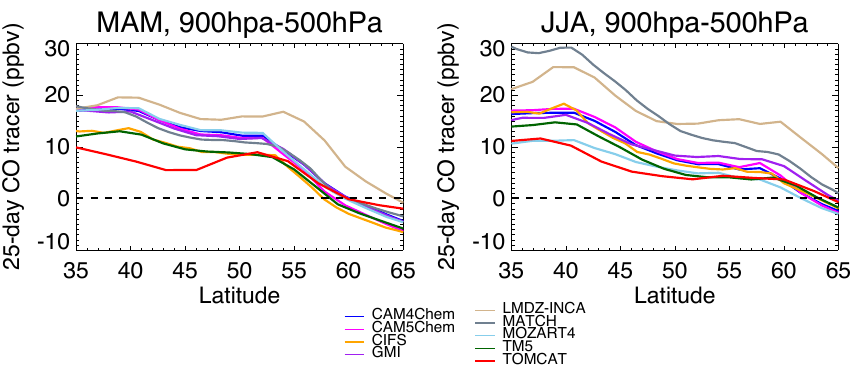
Figure 8. Zonally averaged difference between simulated 25-day fixed-lifetime CO tracer mixing ratios at 900 and 500hPa in the POLMIP model simulations for (a) spring (MAM) and (b) summer (JJA)